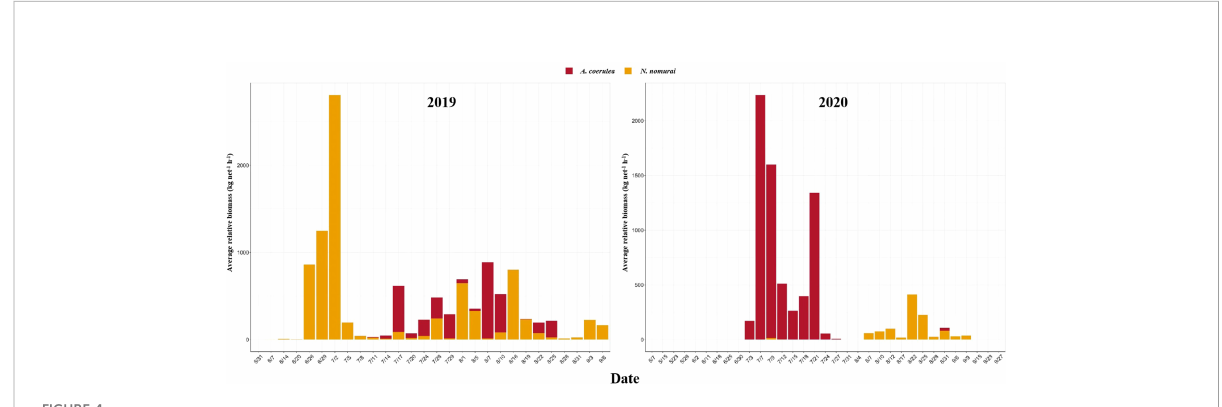
FIGURE 4 The ARB of N. nomurai and A. coerulea at the intake area of the NPCS in 2019 and 2020.